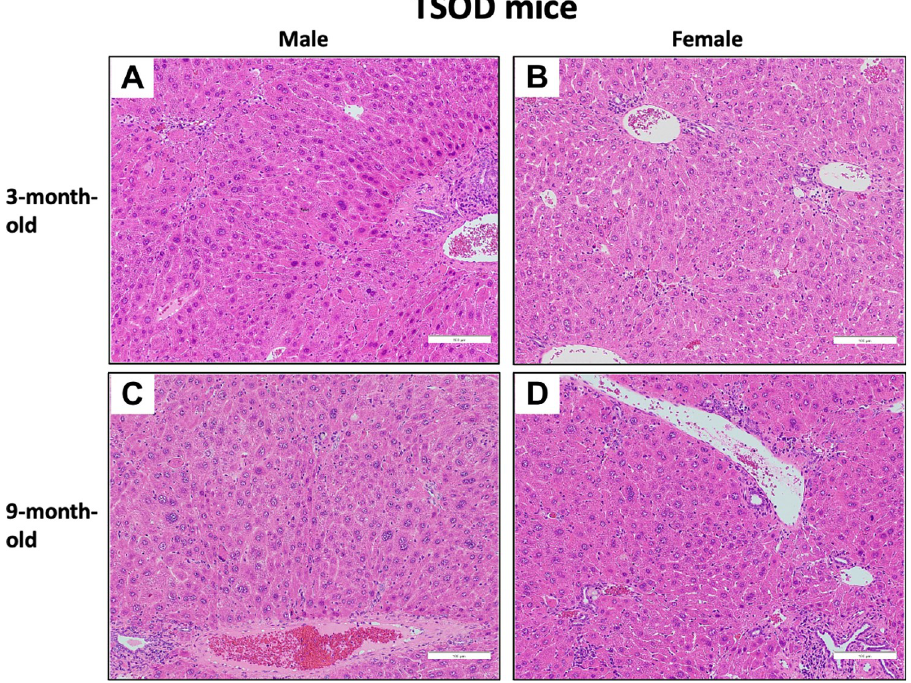
Fig 1. Photomicrographs of the liver of TSOD mice at the ages of 3 and 9 months. A-D) In male and female TSOD mice, intralobular and portal inflammation is observed, although hepatic steatosis and ballooning are not conspicuous. Intralobular inflammation tends to be more severe in male mice than in females at 3 months. (H&E staining, original magnification × 200).